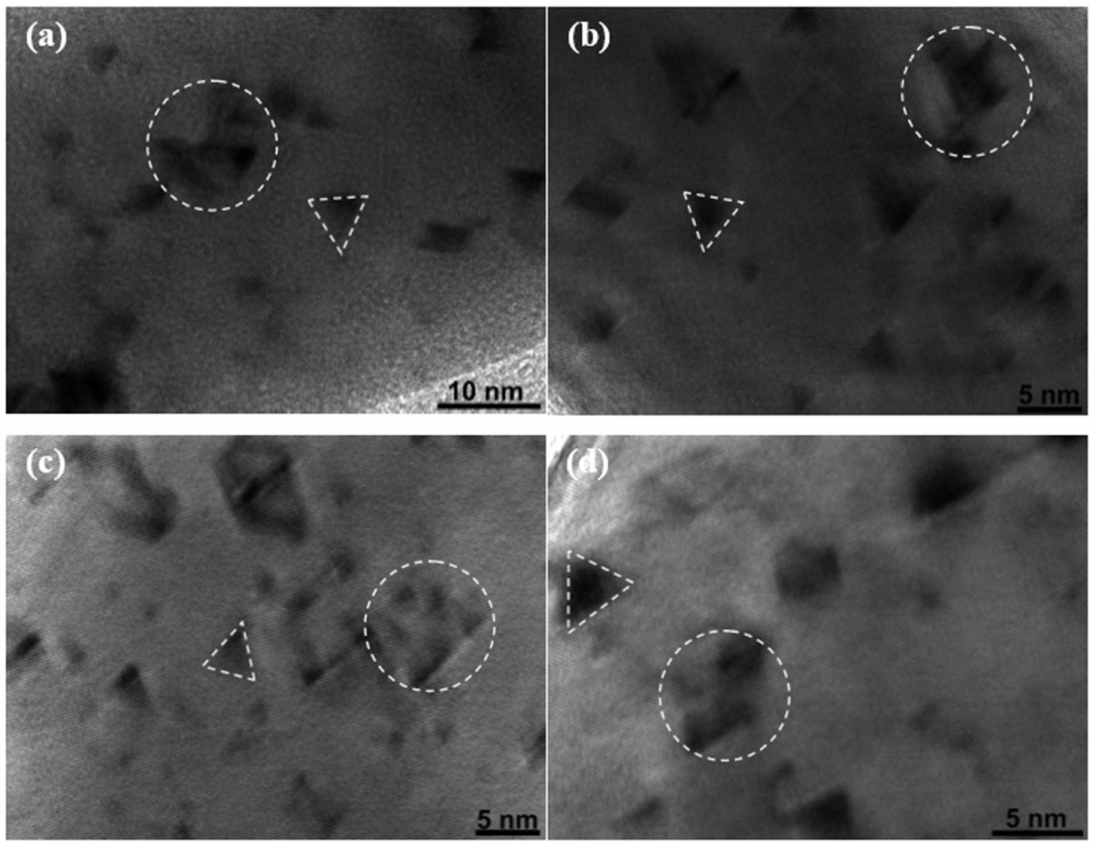
Figure 6. High-resolution TEM micrographs of irradiated gold nanowire. Gold NWs irradiated with ( a ) 1.4 MeV Xe ions, ( b ) 4 MeV Xe, ( c ) 1.4 MeV Kr, and ( d ) 3 MeV Kr. Dashed triangles and circles indicate single stacking fault tetrahedrons (SFTs) and group of intermixed SFTs,